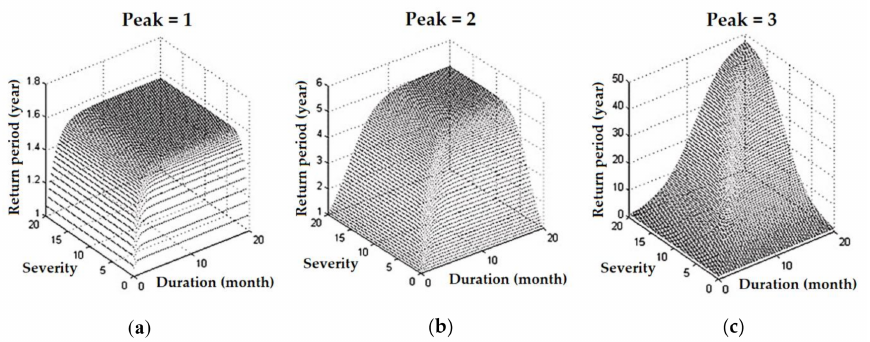
Figure 8. T ∨ for di ff erent values of severity peaks based on one-month TSI for the Rasht Basin: 1 ( a ); DSP 2 ( b ); and 3 ( c ).